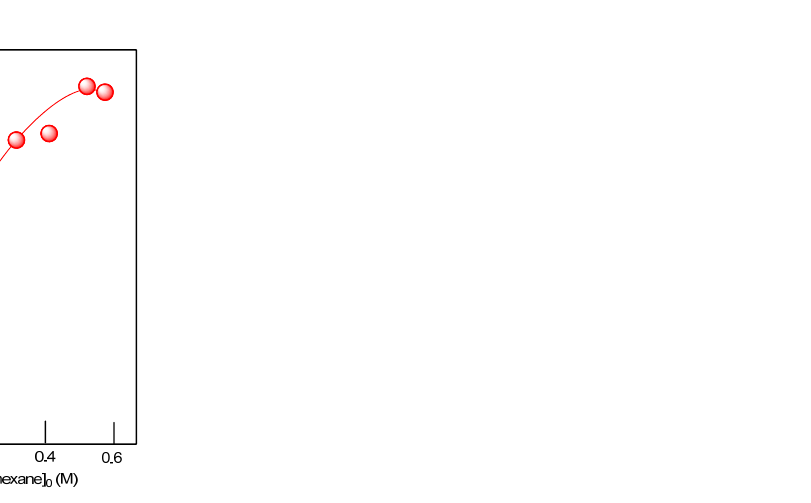
Figure 5. Dependence of the initial rate of oxygenate (sum cyclohexanol+cyclohexanone) formation W 0 for complex 3 on the initial concentration of cyclohexane.